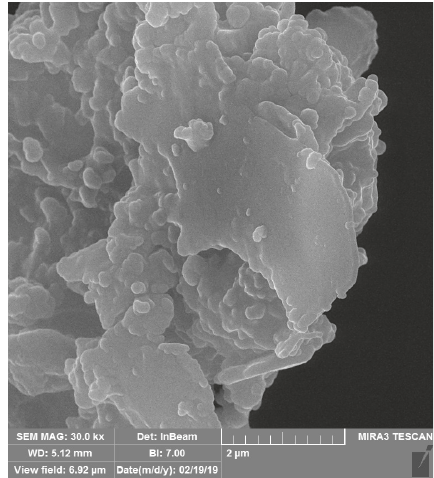
Figure 10: SEM fractograph of 5 wt. % SWCNT nanocomposite.